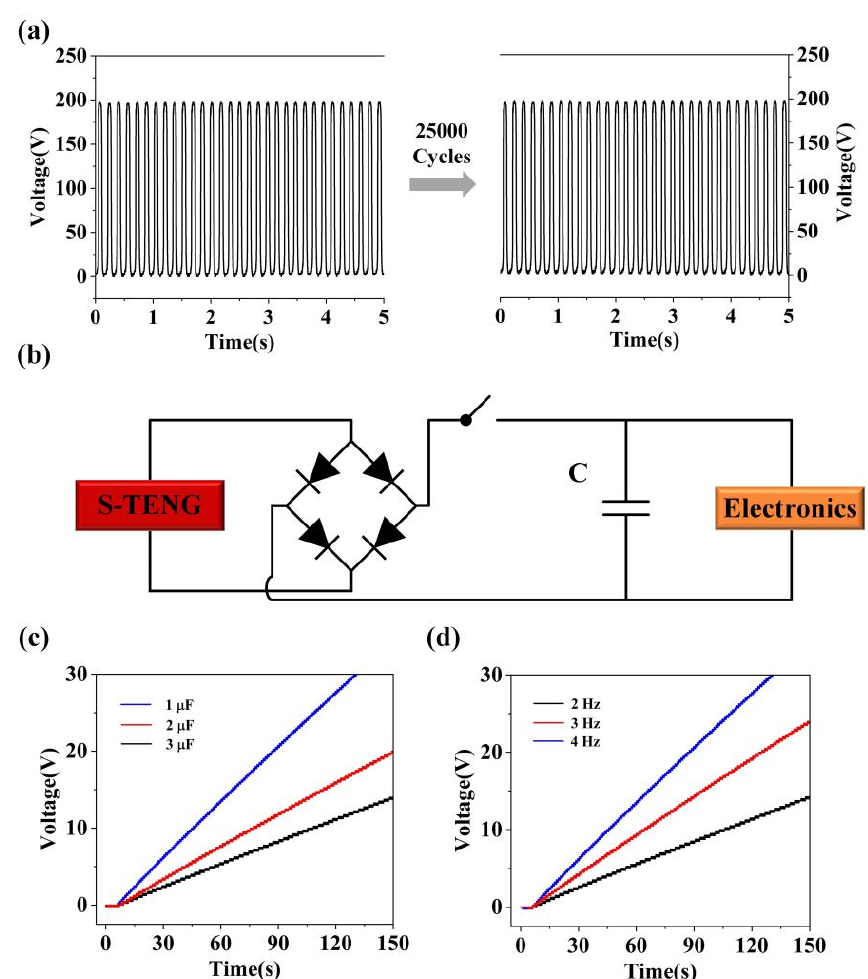
Figure 5. ( a ) The reliability test of S-TENG. ( b ) The schematic diagram of power management circuit based on the S-TENG. ( c ) The charging curve of S-TENG for different capacitors (from 1 µF to 3 µF) under the working frequency of 4 Hz. ( d ) The charging curve of S-TENG for 1 µF capacitor under different working frequencies (from 2 Hz to 4 Hz).